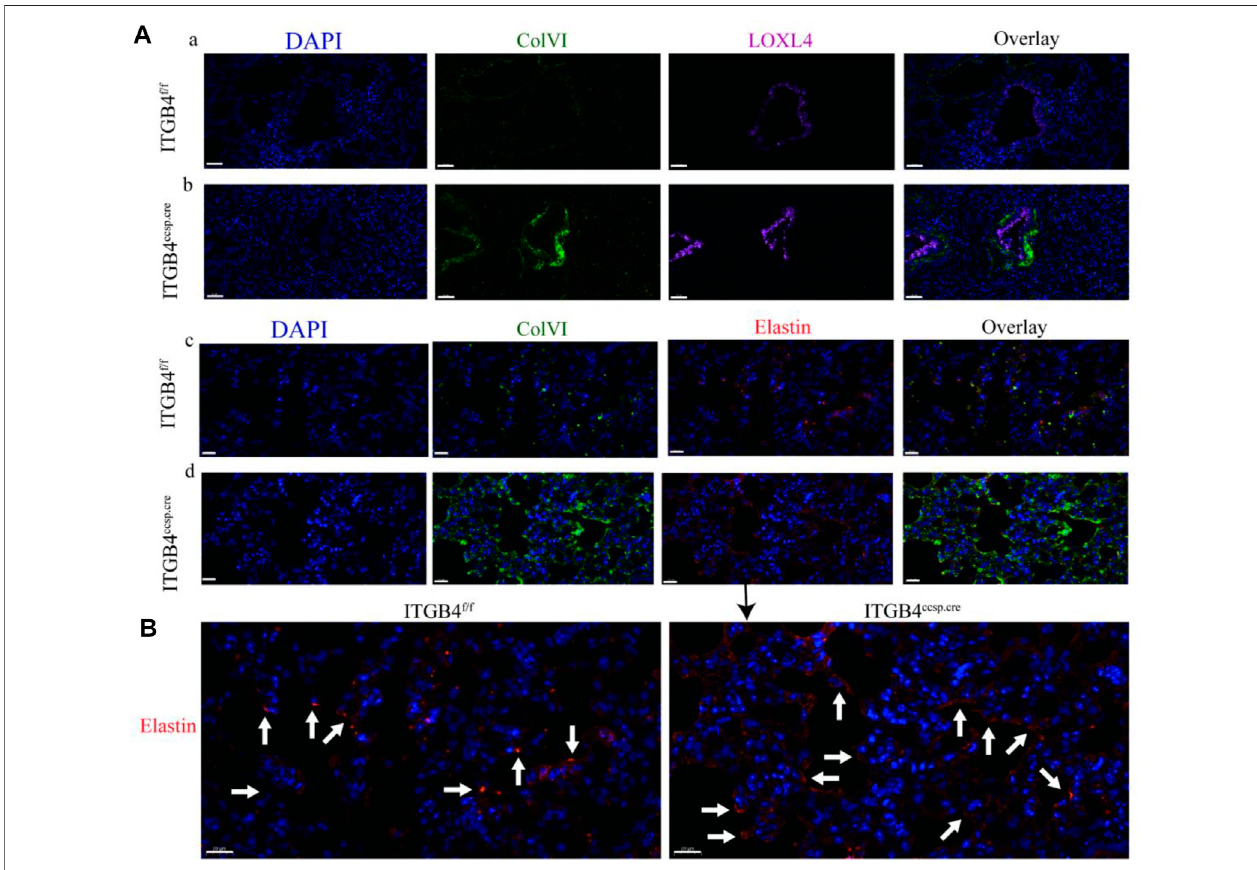
FIGURE 4 | The expression of LOXL4,Col Ⅵ and elastin between ITGB4 f/f and. ITGB4 ccsp.cre mice (A) Immuno fl uorescence images of Col VI (green) and LOXL4 (pink) in the airway epithelium (a, b) and the Col VI (green) and elastin (red) in alveoli (c, d). Scale bars: 50 μ m. (B) Immuno fl uorescence images of elastin in the in alveoli. Scale bars: 20 μ m. Lung elastin accumulation (arrows) was distinctly greater in the ITGB4 ccsp.cre lungs.